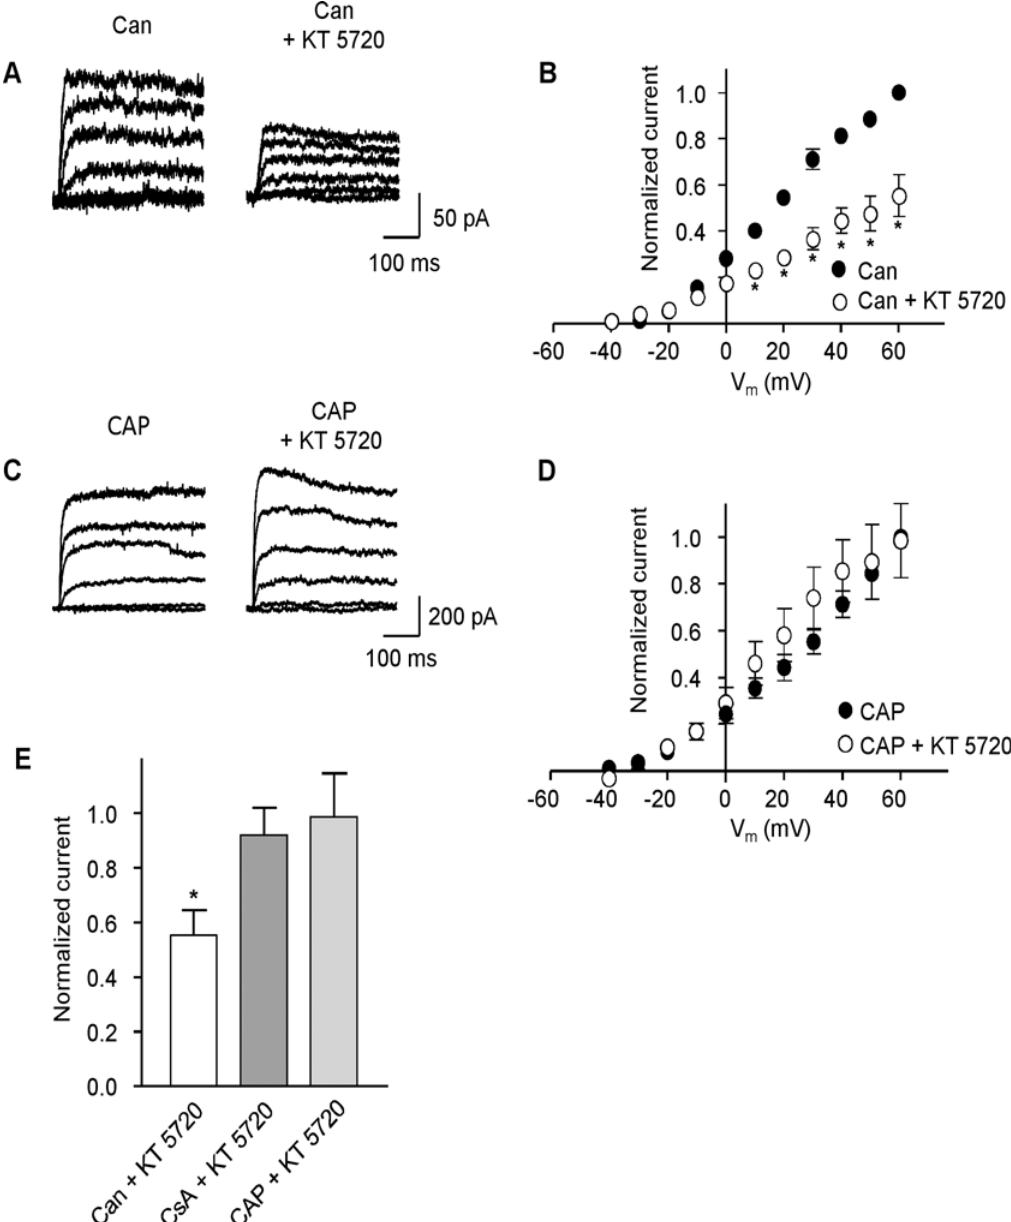
Fig 5. Regulation of K v current in MSMCs involves protein phosphatase 2B (PP2B), but not protein phosphatase 2A (PP2A). ( A ) Representative K v current traces obtained from a cell pre-treated with cantharadin (Can, 30 μ M) for 10 min before and after application of KT 5720 (1 μ M). ( B ) Mean ( ± s.e.m.) I-V plots, normalized to current in the presence of cantharadin (30 μ M) at +60 mV, before and after the application of KT 5720 (1 μ M, n = 4, * P < 0.05; two-way ANOVA, Bonferroni ’ s post hoc test). ( C ) Representative K v current traces obtained with PP2B/calcineurin auto-inhibitory peptide (CAP, 100 μ M) in the patch pipette before and after application of KT 5720 (1 μ M). ( D ) Mean ( ± s.e.m.) I-V plots, normalized to current in the presence of CAP at +60 mV, before and after application of KT 5720 (1 μ M, n = 5). € Mean ( ± s.e.m.) current at +60 mV (normalized to respective controls) following application of 1 μ M KT 5720 in cells pre-treated with cantharadin (Can, 30 μ M, n = 4), cyclosporin A (CsA, 4 μ M, n = 7), or with CAP (100 μ M; n = 5) in the pipette as indicated ( * P < 0.05; one-way ANOVA, Bonferroni ’ s post hoc test).